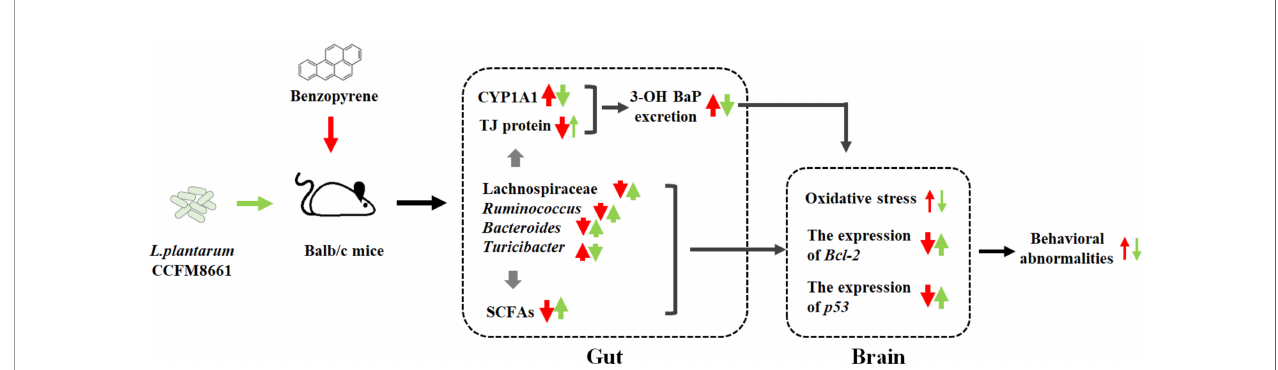
FIGURE 9 | The possible protective mechanisms of L. plantarum CCFM8661 against B[a]P toxicity in the gut and brain. The red and green arrows represent the B[a]P- and CCFM8661-induced parameter changes, respectively. The thin arrows represent that only part of the parameter is